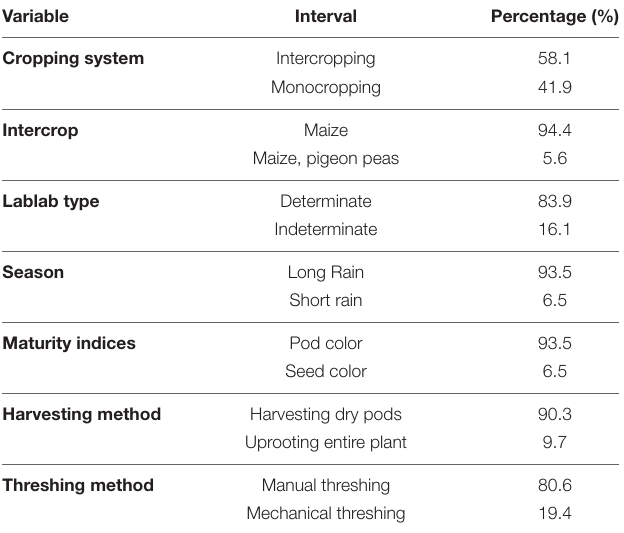
TABLE 2 | Cropping and harvesting practices.